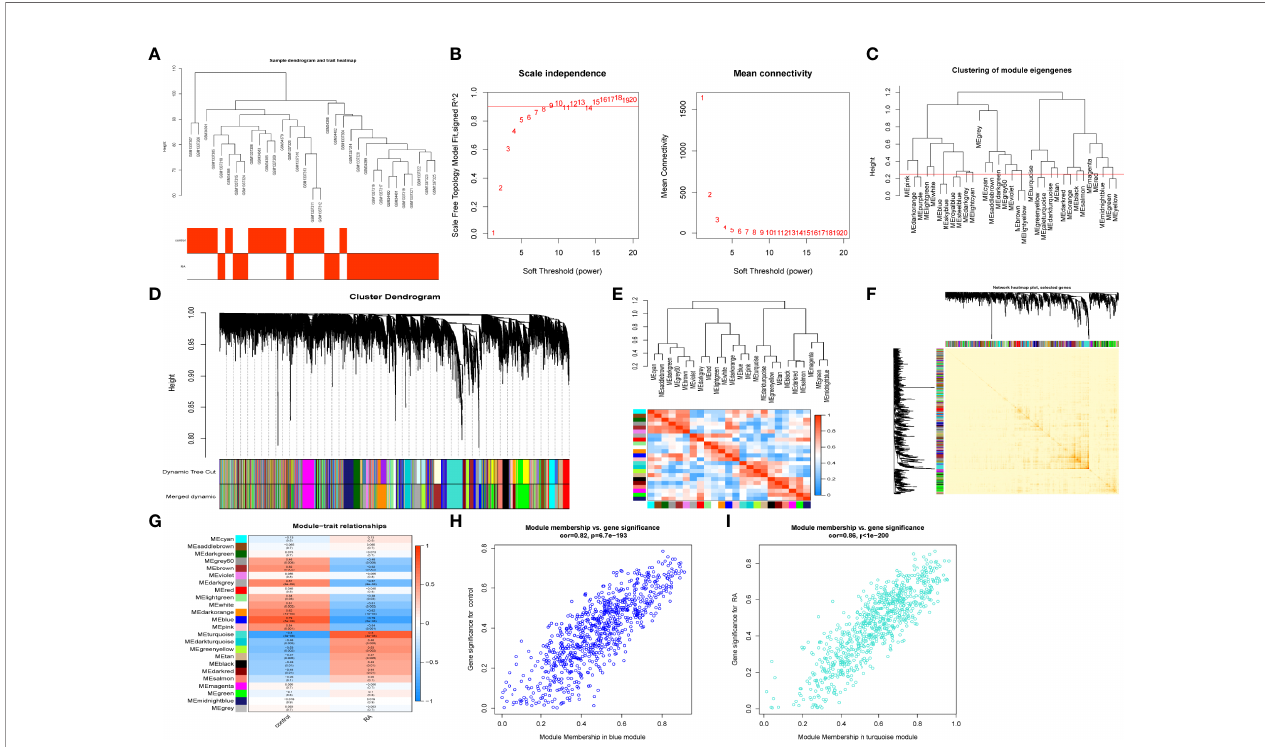
FIGURE 2 | Construction of WGCNA co – expression network. (A) Sample clustering dendrogram with tree leaves corresponding to individual samples. (B) Soft threshold b = 7 and scale – free topological fi t index (R2). (C) Clustered dendrograms were cut at a height of 0.25 to detect and combine similar modules. (D) Shows the original and combined modules under the clustering tree. (E) Collinear heat map of module feature genes. Red color indicates a high correlation, blue color indicates opposite results. (F) Clustering dendrogram of module feature genes. (G) Heat map of module – trait correlations. Red represents positive correlations and blue represent negative correlations. (H) MM vs. GS scatter plot of control. (I) MM vs. GS scatter plot of